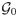
Effect of overstimulation of one parameter in the random models GR and GR,C.The diffusion is moderate and the noise is low. Every panel represents the particular realizations of iJINF,max, iip3,max and ccyt in the graph G0 at four particular time points. (A) Model GR. The system is sufficiently sensitive and inhomogeneous to produce spirals. We set μiIP3,max=1.8 and μiJINF,max=0.6. (B) A more sensitive zone is added at the center of the graph (model GR,C) with μiIP3,max,1=2.6 and μiJINF,max,1=0.7 (again with μiIP3,max,0=1.8 and μiJINF,max,0=0.6). Concentric circles appear. (C) The previous system is overstimulated with μiIP3,max,1=5.5 and μiIP3,max,0=4 (other parameters as in (B)), which results in incoherent behavior and spirals. All parameters are set according to Table 1, except if specified. The standard deviations in the central zone are σiIP3,max,1=0.01, σiJINF,max,1=0.001 and σt1,1=0. μt1,1 is set to the minimal value of t1(v)for v∈V0\V˜1.